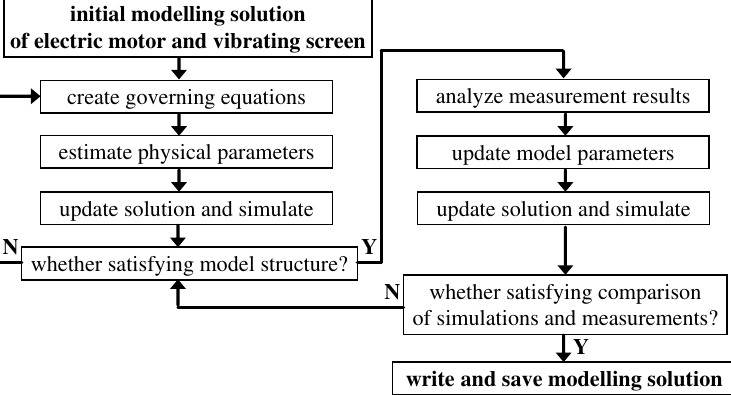
Figure 3. Flowchart for the procedure of modeling and identification of the vibrating screen